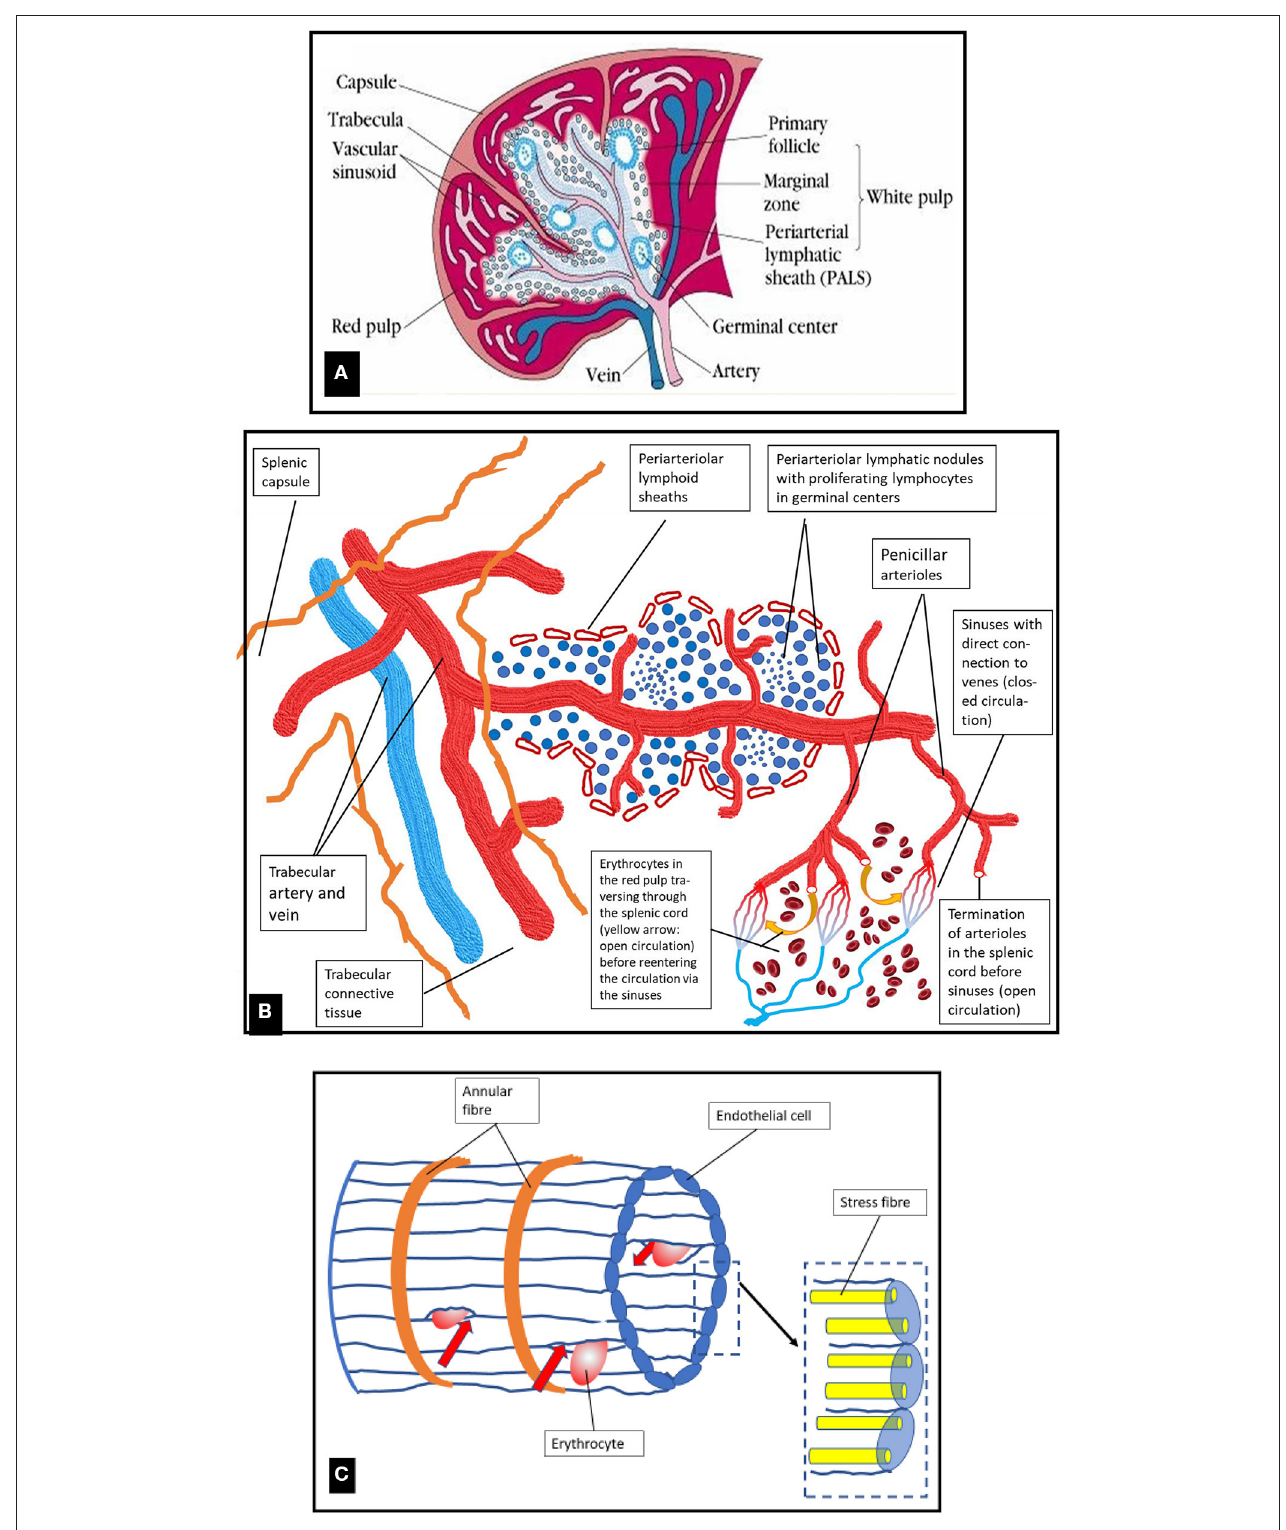
FIGURE 2 | (A) Organization of macroscopic visible structures in the human spleen and schematic presentation of blood vessels and white and red pulp. Original photo from (6). (B) Schematic diagram of the microstructure of the spleen. For details see text. (C) Schematic drawing of a venous sinus located in the red pulp cords. Blood cells from the cords are only collected into the venous sinuses if they manage to pass the slits between the endothelial cells (shown by red arrows). Figure modified from (7).